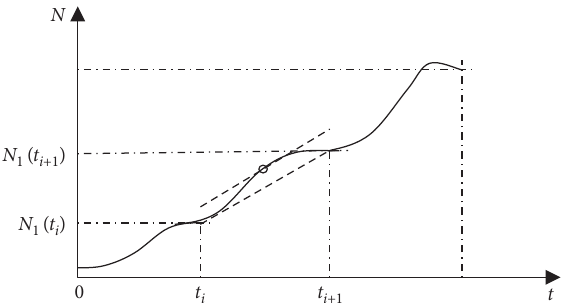
Figure 1: Population density evolution curve based on the logistic